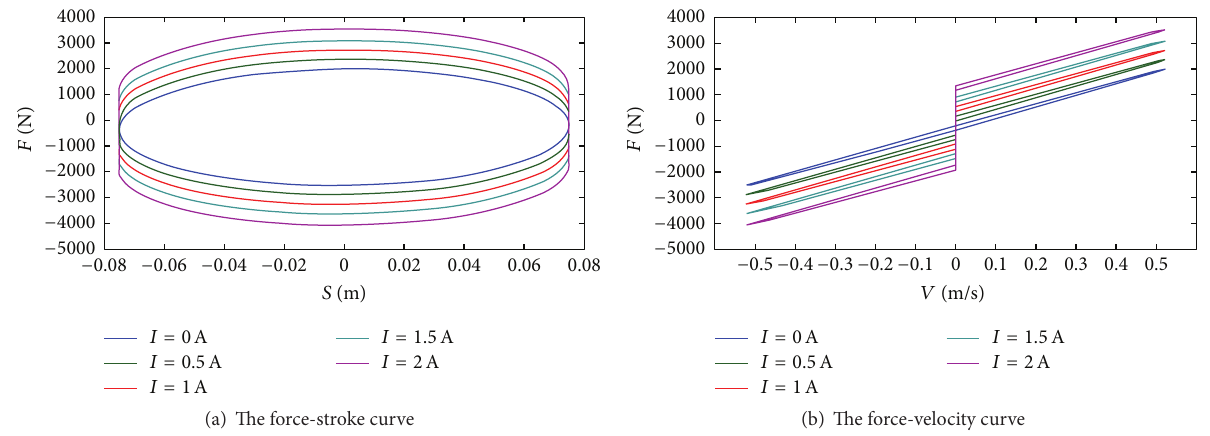
Figure 6: The 𝐹 - 𝑆 and 𝐹 - 𝑉 curves of MRD with annular radial